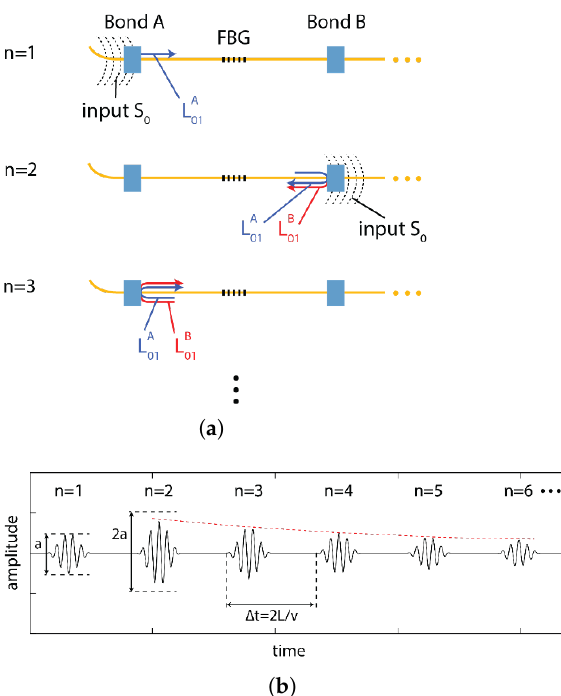
Figure 23. Concept for self-referencing ultrasound sensor. ( a ) Pathways for first three arriving wave packets at FBG (n = 1, 2, 3, ...) and ( b ) corresponding theoretical output FBG responses with the wave number, n. [166].